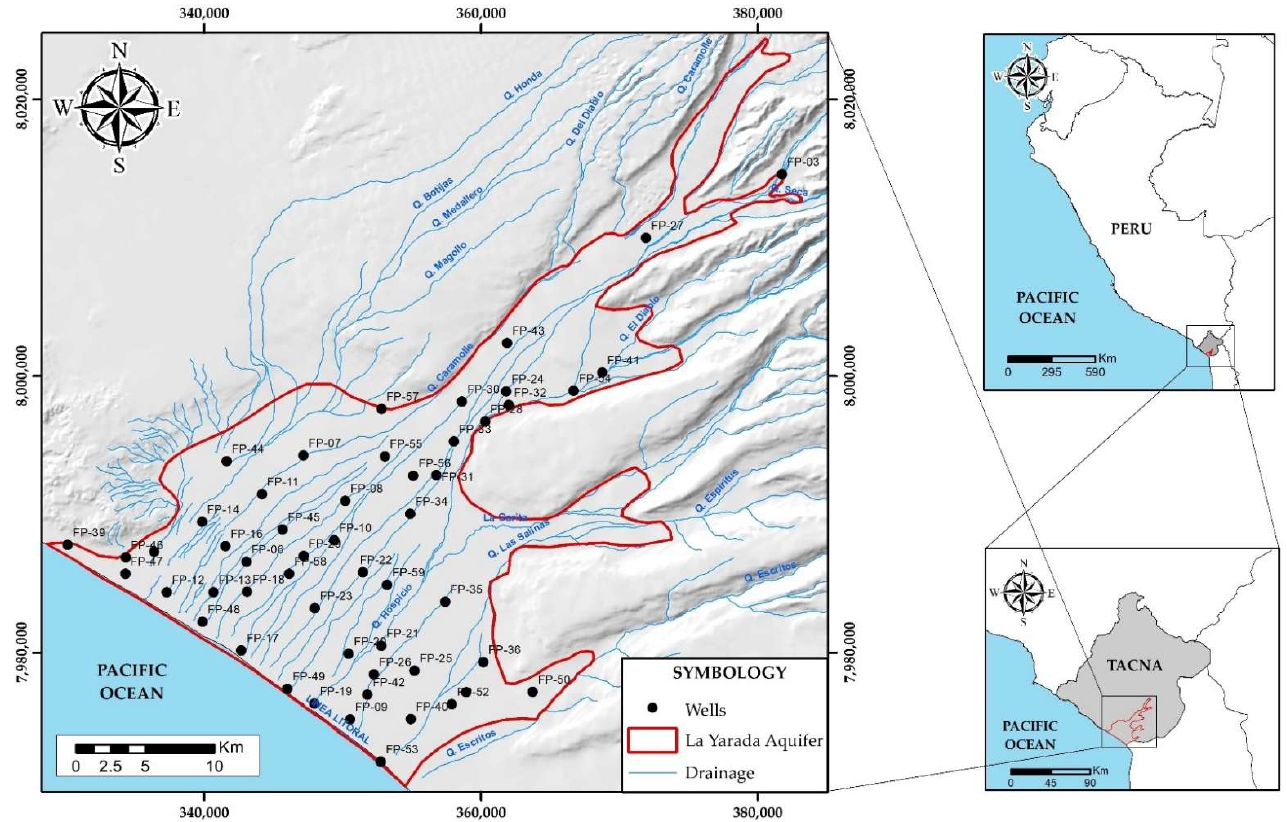
Figure 1. Location of the aquifer of La Yarada.